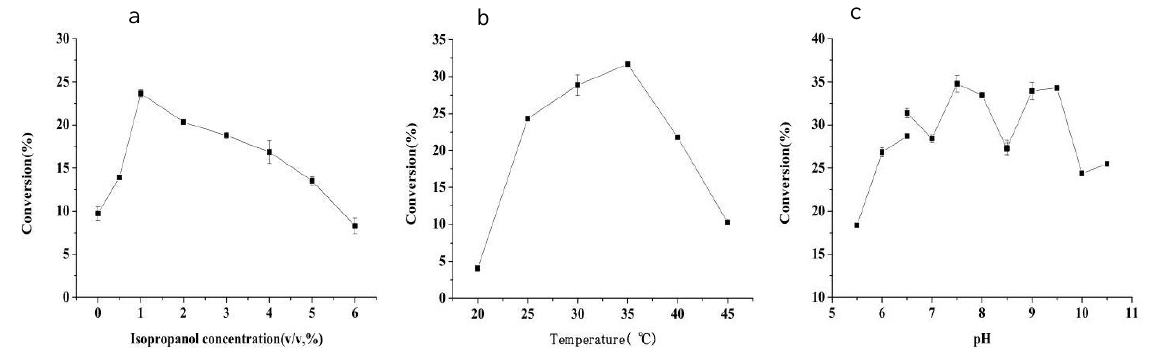
Figure 4. Characterization of EbSDR8 mutant M190V. Reaction condition: isopropanol, 0.025 g wet resting cells, 200 mM of acetophenone, and 500 μL reaction mixture. Error bars indicate the standard deviations. ( a ). The effect of isopropanol concentration (0–6%) on the M190V whole-cell-catalyzed asymmetric reduction of acetophenone. ( b ). The effect of temperature (20–45 °C) on the M190V whole-cell-catalyzed asymmetric reduction of acetophenone. ( c ). The effect of buffer pH (citrate buffer, 5.5–6.5; Sodium phosphate buffer, 6.5–8.5; glycine-NaOH buffer, 8.5–10.5) on the M190V whole-cell-catalyzed asymmetric